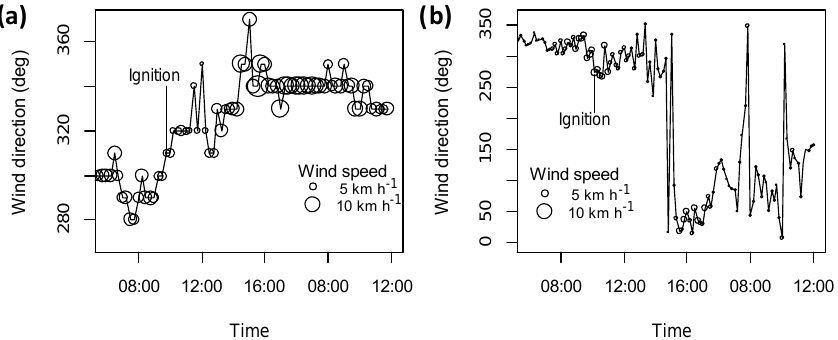
Figure 3. Wind direction and speed recorded during the fires: (a) from Lucas Heights for the 52ha fire and (b) from the mobile weather station for the 700ha